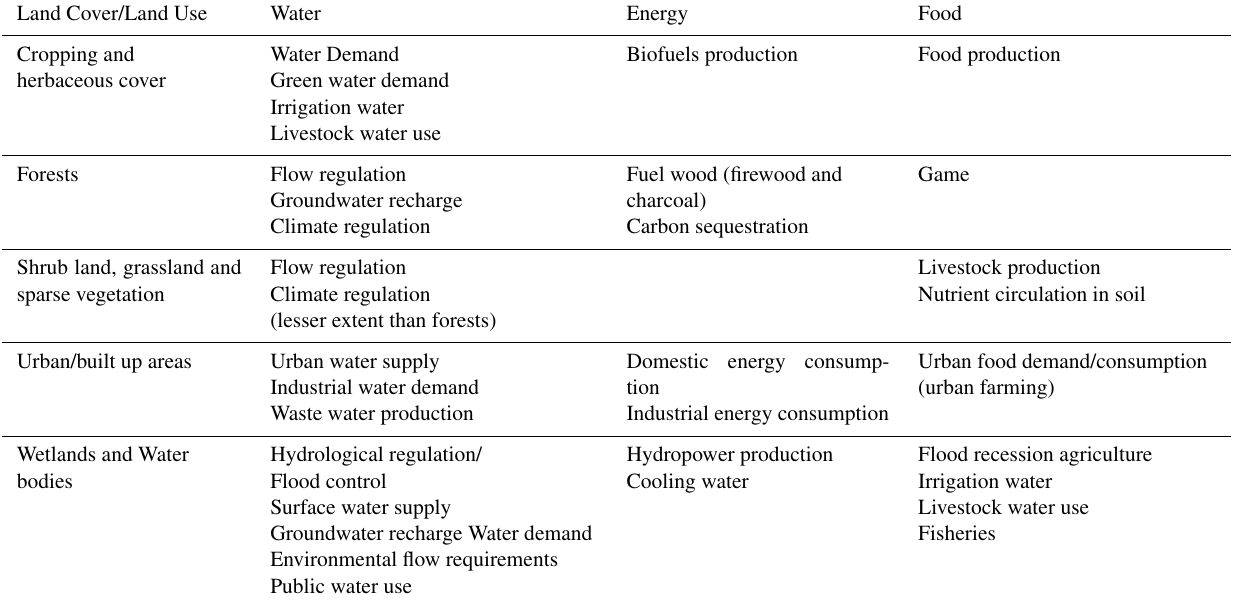
Table 1. Water–energy–food ecosystem services associated with land cover types. Land Cover/Land